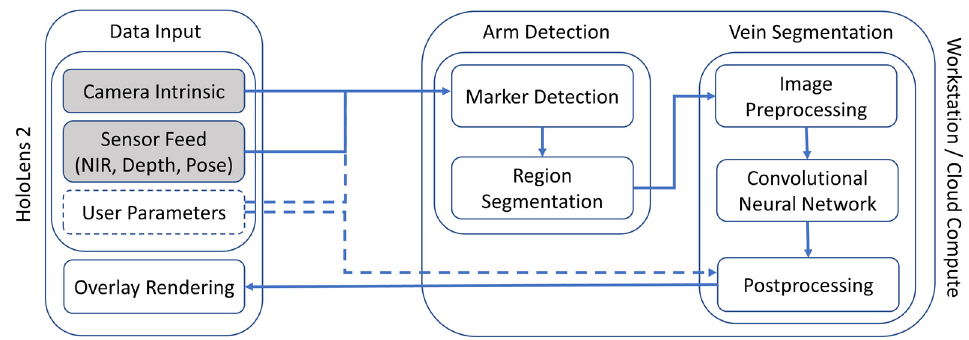
Figure 2. Illustration of deployed system data flow and algorithms. Shaded boxes indicate live data feed retrieved from the on-board sensors/algorithms (Depth camera, SLAM). Dotted regions indicate optional inputs/parameters. The system is split into two main components—HoloLens 2 and Workstation/Cloud (off-site computing). Off-site computation can further be split into Arm Detection and Vein Segmentation steps.